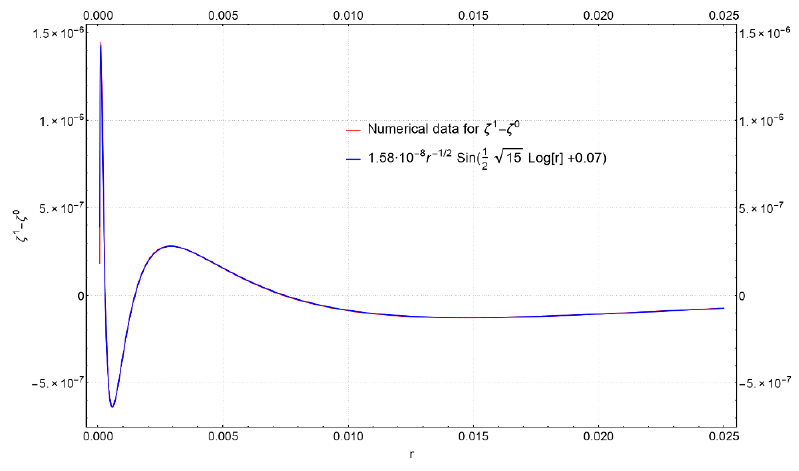
Figure 15 . The warp factor di(cid:11)erence (cid:12)t for ~ (cid:16) 1 (cid:0) ~ (cid:16) 0 for M = R 2 (cid:2) S 2 (cid:2) S 2 , ~ (cid:26) = 10 (cid:0) 5